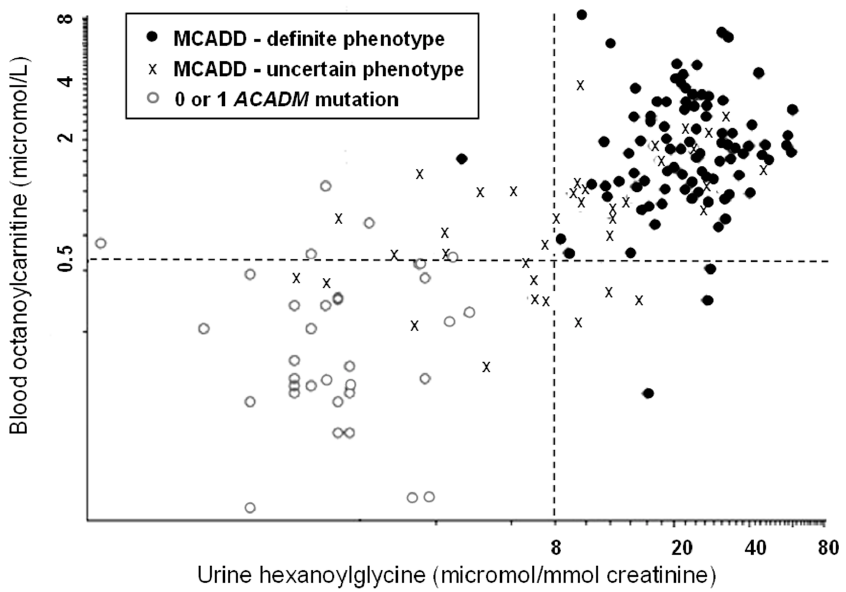
Figure 1. Metabolites in samples taken at clinical evaluation following a presumptive-positive initial result (blood-spot octanoylcarnitine ≥ 0.5 micromol/L). Data points are taken from Oerton et al. [1]. The “cut-off” shown for hexanoylglycine is empirical; the upper limit of normal by the method used was 1.1 micromol/mmol creatinine [5].